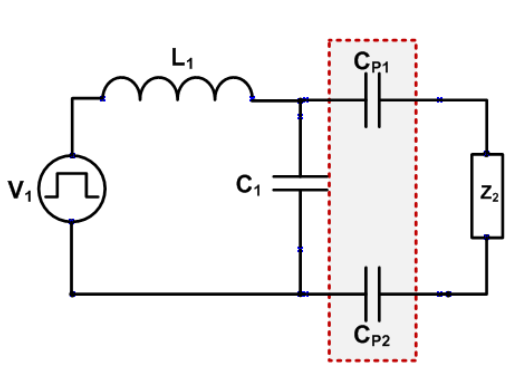
Figure 4. Equivalent circuit of Z-Tank modified.